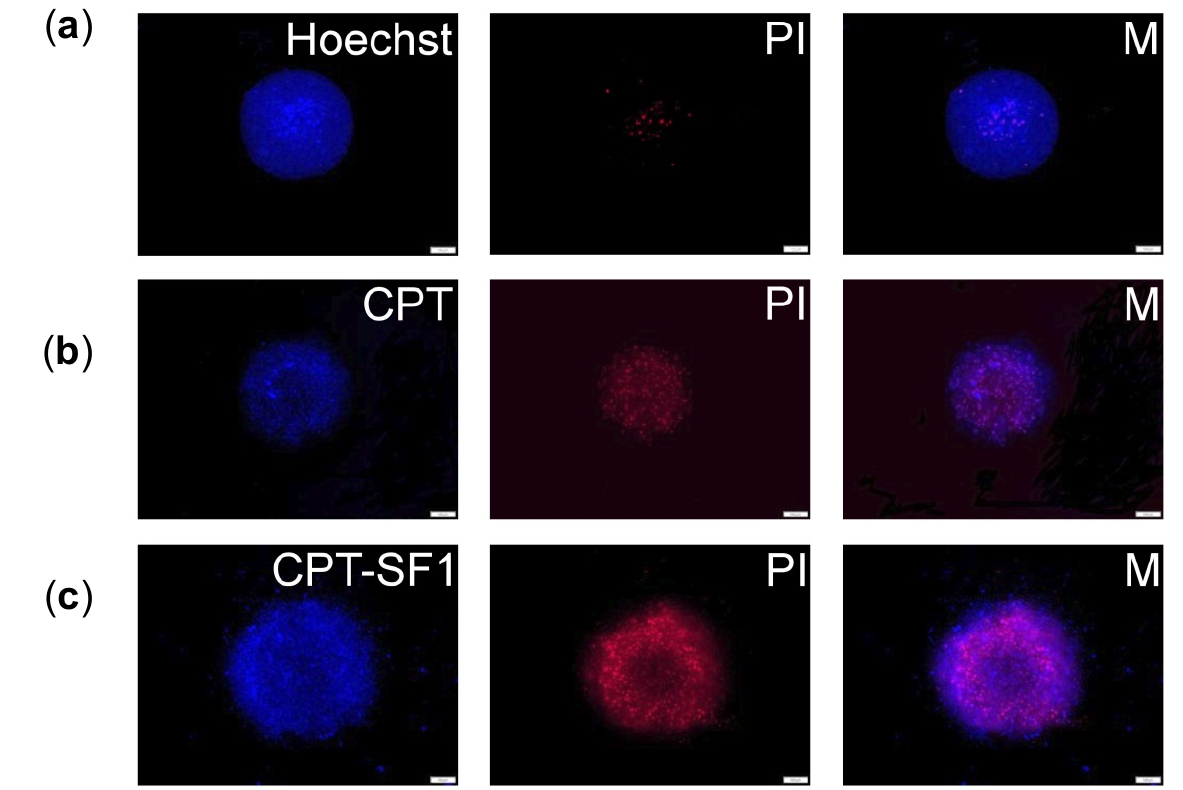
Figure 8. ( a ) MCF-7 spheroid fluorescence images without particles and PI or Hoechst staining. ( b ) Spheroids with 0.1 mg/mL of CPT, PI, and combined pictures (M); ( c ) Spheroids with 0.1 mg/mL of CPT–SF1, PI, and combined pictures (M). Scale bars are 100 µm (see structures in Figure 1).